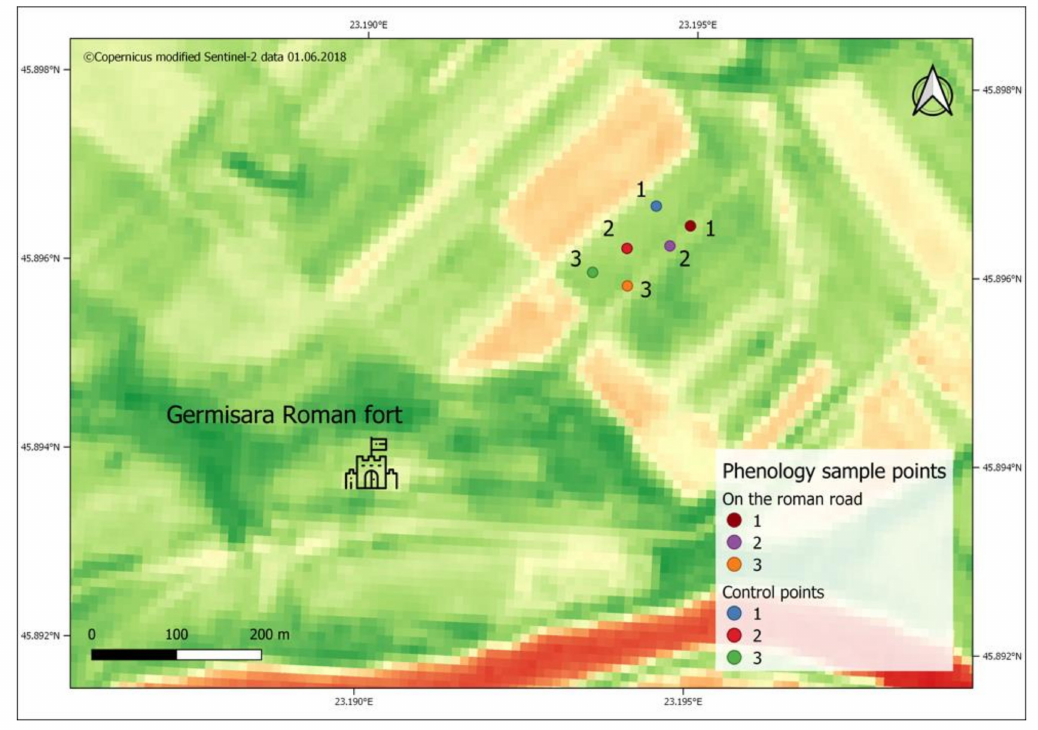
Figure 16. Plant phenology analysis performed in six points located within the agricultural parcel crossed by the Roman road from the Cigm ă u fort to the baths in Geoagiu–B ă